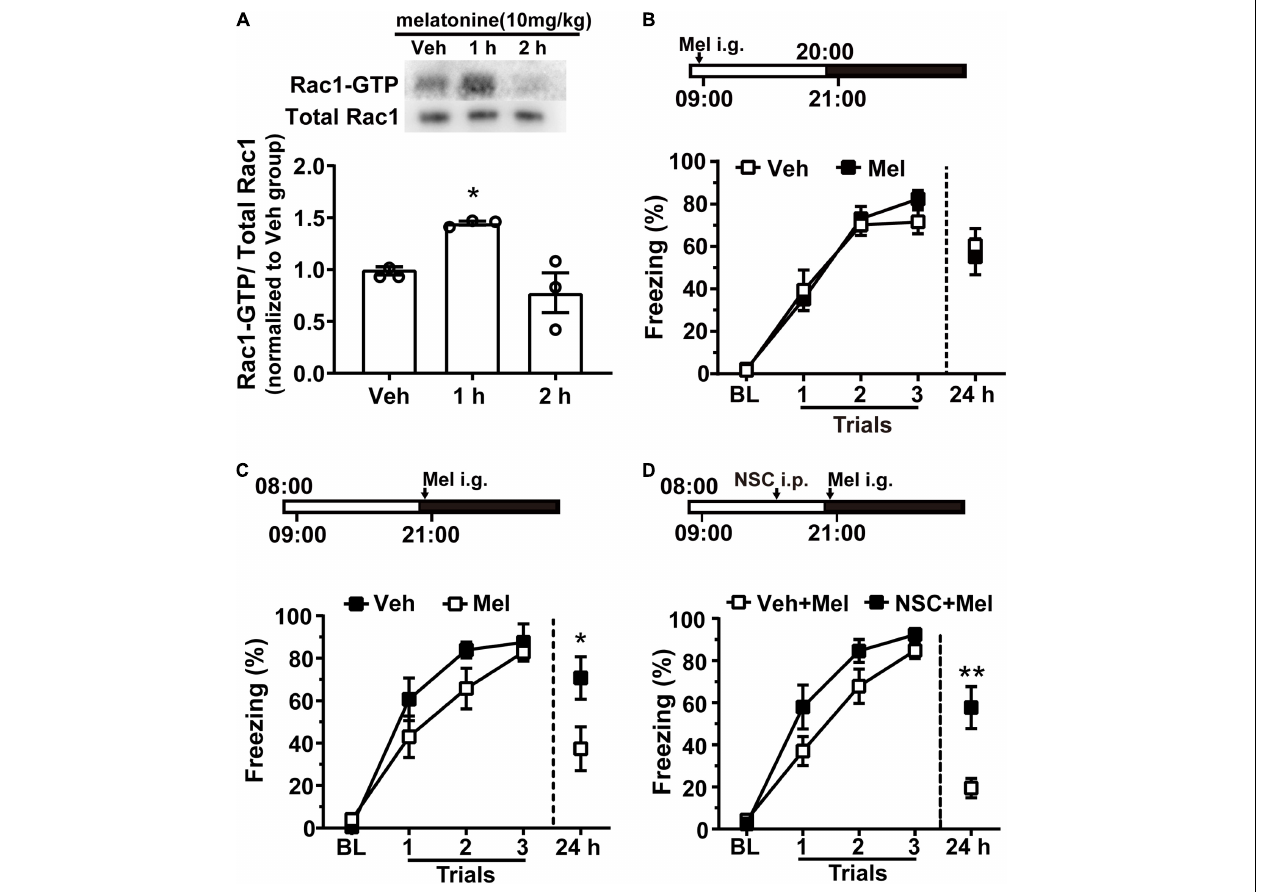
FIGURE 4 | Melatonin treatment promotes hippocampal Rac1 activity and impairs the better contextual fear memory acquired at the night. (A) Melatonin activated hippocampal Rac1. Upper panel: representative WB demonstrated that melatonin obviously activated Rac1 at 1 h after administration. Lower panel: the statistical bar graph showed an obvious activation of Rac1-GTP in the 1 h group compared with the vehicle group. (B) There was no difference between the vehicle and melatonin group in learning curve and 24 h memory test when training at 09:00. (C) The learning curve of the vehicle group and melatonin group was similar when training at 21:00 but melatonin treatment impaired contextual fear memory tested in 24 h after training. (D) Inhibition of Rac1 activity compensated for the effect of melatonin on contextual fear memory when training at the night. Contextual fear memory was significantly increased in the NSC + Mel group compared to the Vel + Mel group at 24 h after learning. Data are presented as mean ± SEM. * p < 0.05, ** p <